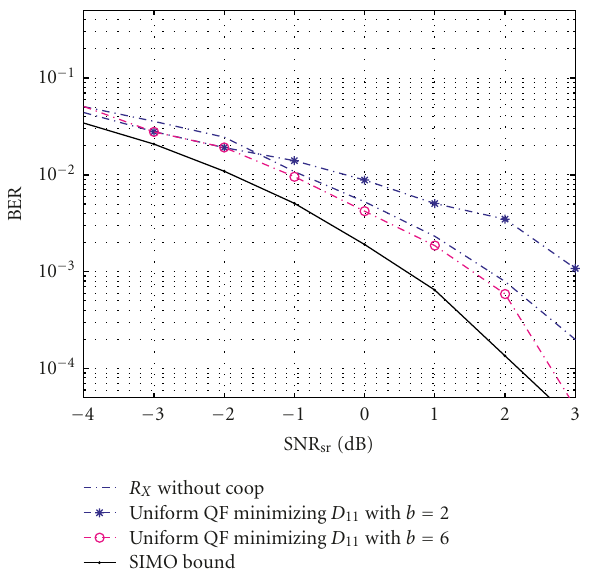
Figure 3: Influence of b on the performance when the uniform QF protocol is used over static channels: raw BER versus SNR sr at the output of the MRC for SNR rd = 10dB with SNR sr = SNR sd − 5dB.